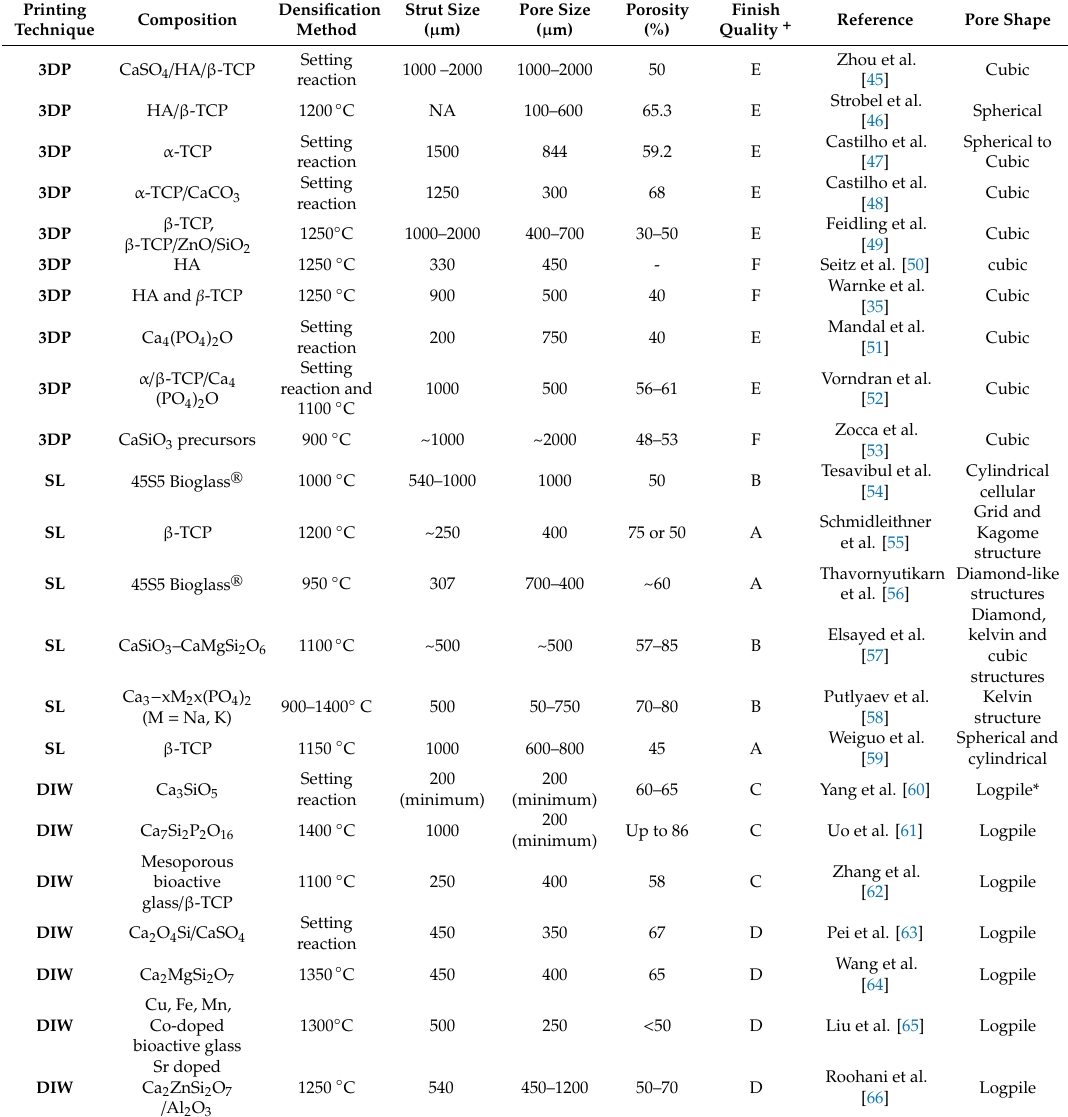
Table 1. Various bioceramic compositions printed by common additive manufacturing